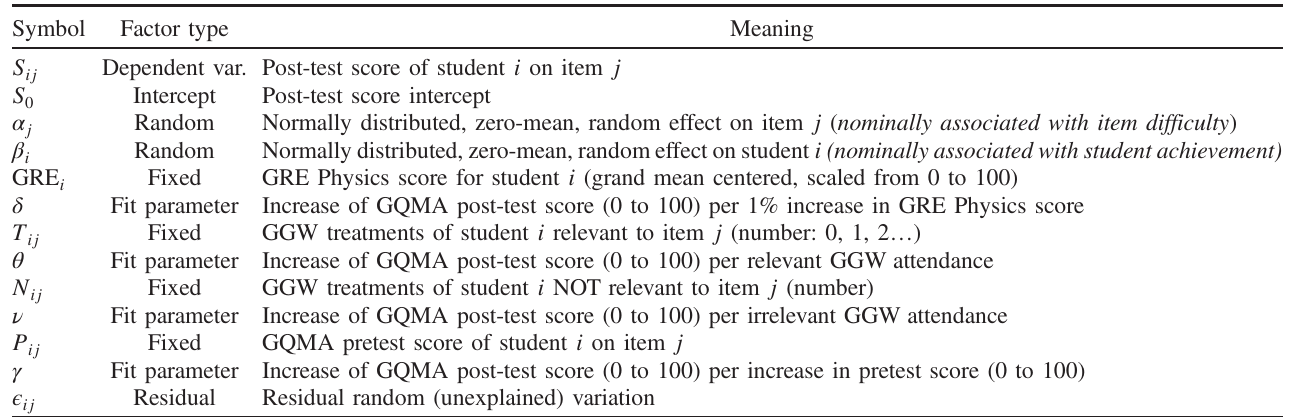
TABLE III. Parameters used in the mixed linear model of student post-test performance on continuum-scored GQMA items. Symbol Factor type Meaning S ij Dependent var. Post-test score of student